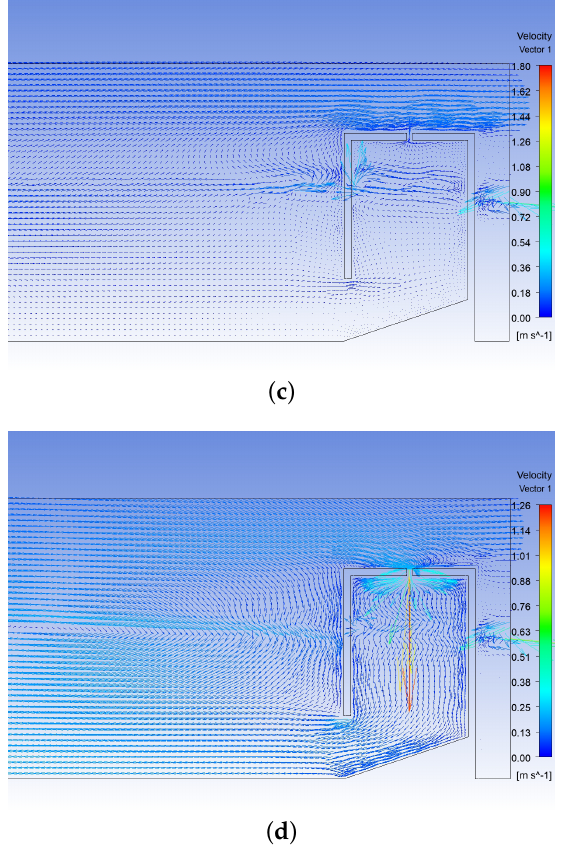
Figure 6. Velocity-vector profile at various time instants: ( a ) t = 110 s, ( b ) t = 130 s, ( c ) t = 190 s, and